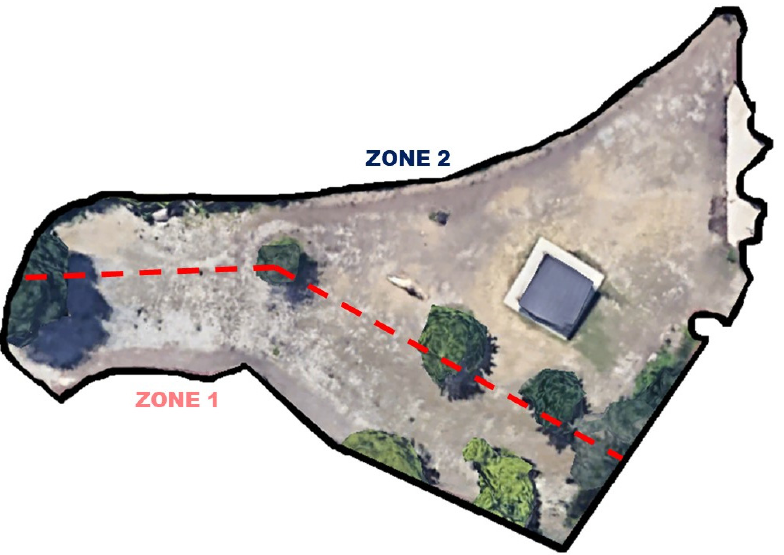
Figure 1. Map of the 1249 m 2 banteng habitat with a red line demarcating the study zones. Map of Saint Louis Zoo, Google Earth. Retrieved from earth.google.com/web/ (accessed on 20 April 2020).